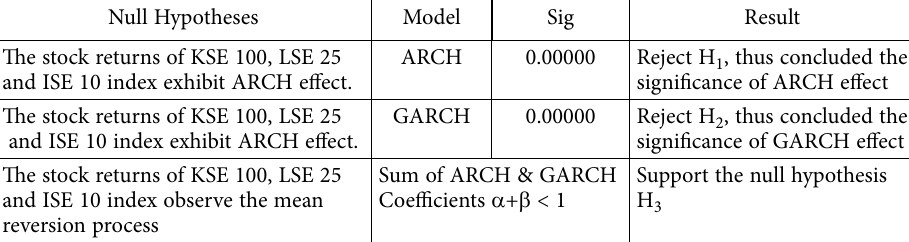
Table 6. Hypotheses tests summary (source: authors’